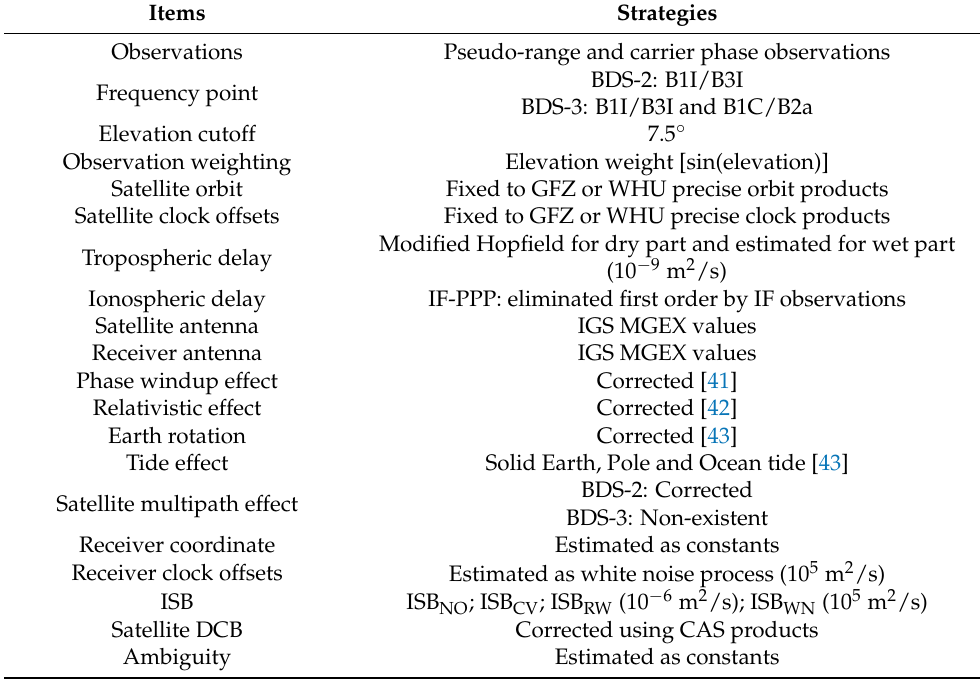
Table 3. BDS precise point positioning (PPP) processing